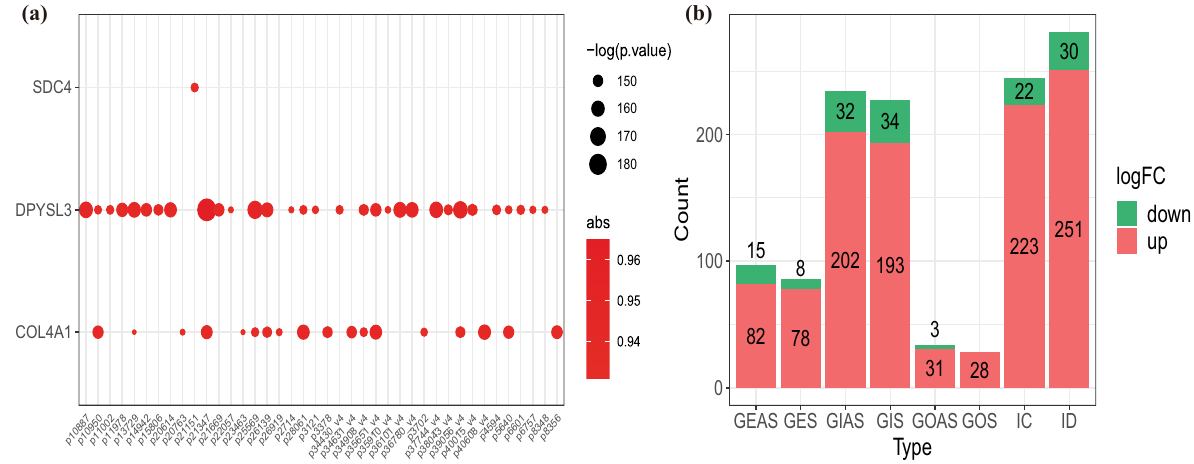
Figure 2: Identi fi cation of EMT - related lncRNAs in CAD. ( a ) Correlation analyses for EMT - related lncRNAs. ( b ) Classi fi cation bar diagram of EMT - related